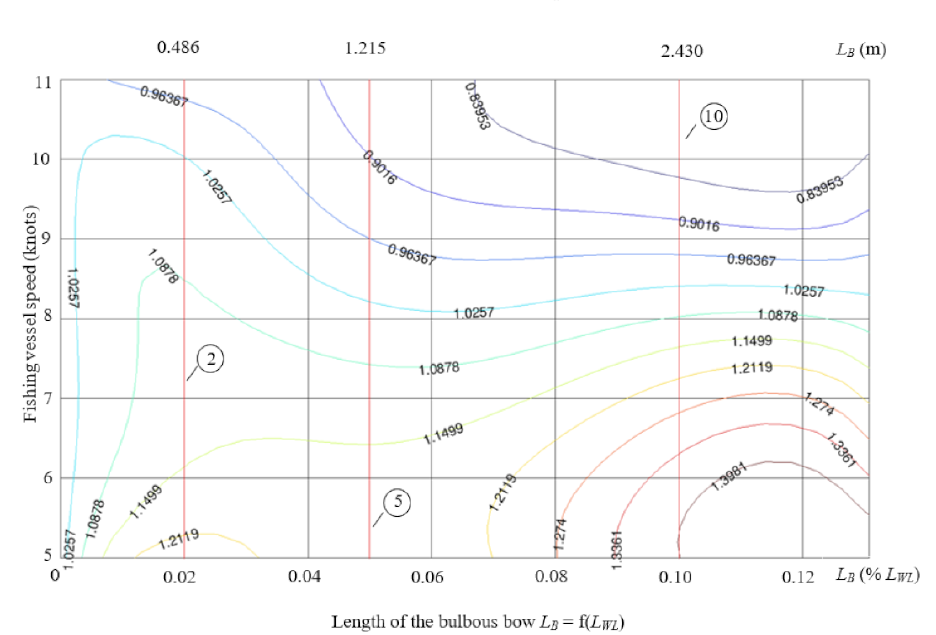
Figure 10. The effects of additional bulbous bow (for different bulbous bow lengths) on the resistance of the fishing vessel, for different speeds: relative resistance value w R < 1.0—reduction of resistance for the modified fishing vessel; relative resistance value w R > 1.0—increase of resistance for the modified fishing vessel (in relation to a fishing vessel without a bulbous